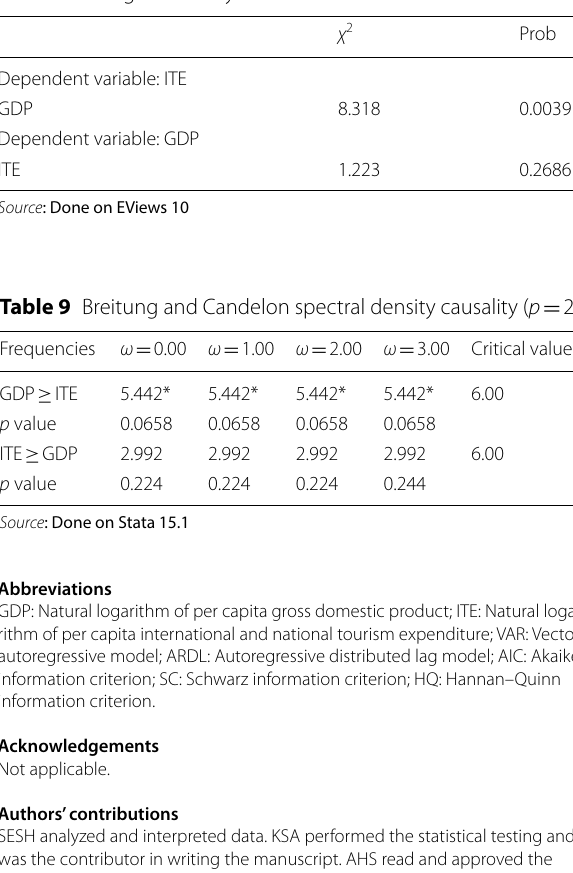
Table 8 Granger causality in the short term